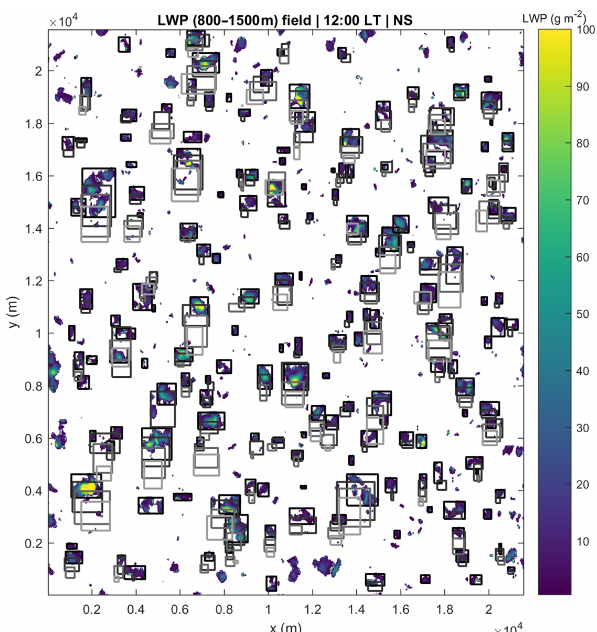
Figure 3. LWP (between 800 and 1500m) field at 12:00LT for the NS simulation. The tracked clouds are highlighted by rectangles, where black lines represent the current time step and match the LWP field. Earlier time steps are represented by progressively lighter grey colours, to a maximum of three time steps earlier than the LWP